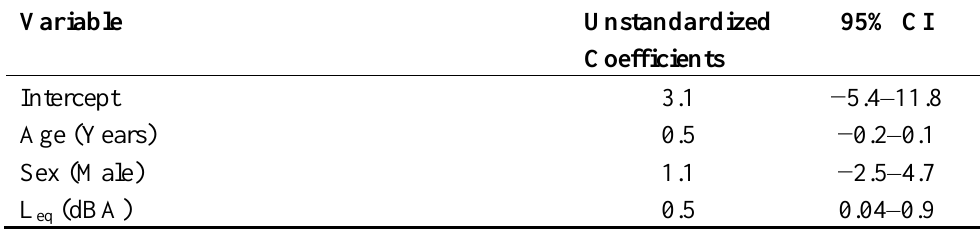
Table 5. Linear regression model of the standard deviation of heart rate (bpm) over entire monitoring